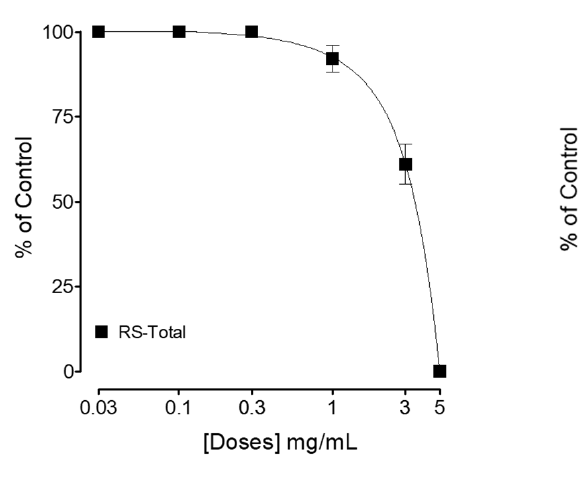
Figure 1. Concentration-dependent inhibitory (bronchodilatory) effects of ( A ) R. stricta toal extract (RS-Total), ( B ) Factions namely; R. stricta ethyl acetate (RS-E), R. stricta petroleum (RS-P), R. stricta chloroform (RS-C) and R. stricta aqueous (RS-H) against carbachol (CCh; 1 μ M) induced contraction in isolated guinea pig tracheal preparations. Symbols represent mean ± SEM; n = 4.